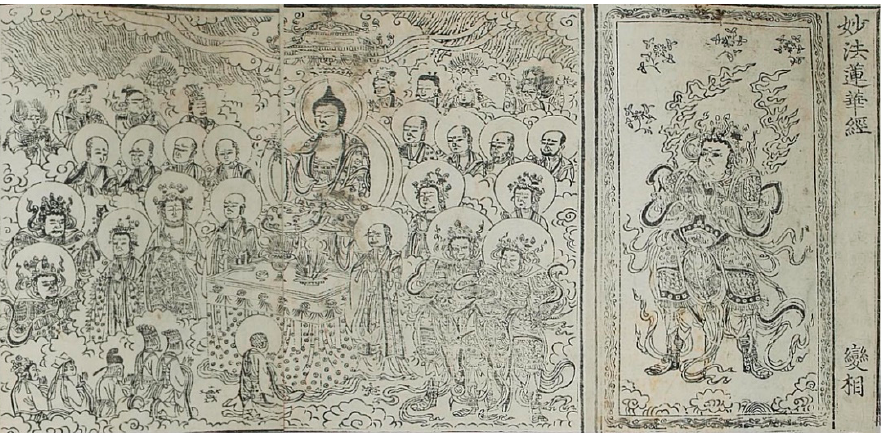
Figure 13. Lotus Sutra, published at Cheonggyesa Temple, Joseon (1622), 20.2 × 13.5 cm, private collection. Photo by the author.